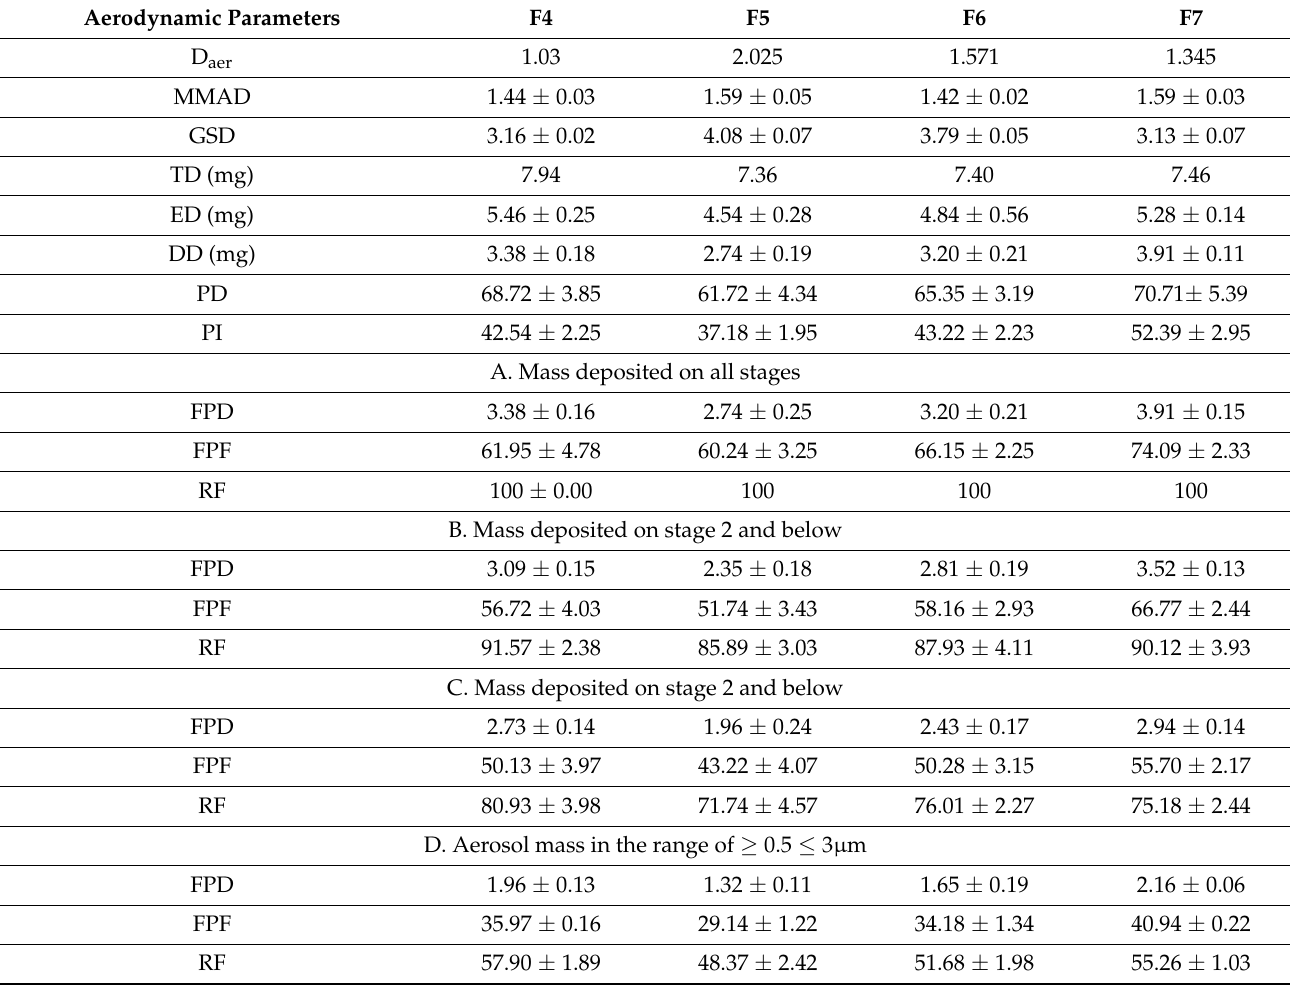
Table 5. Aerodynamic performance of the spray-dried rifampicin loaded microparticles. Aerodynamic